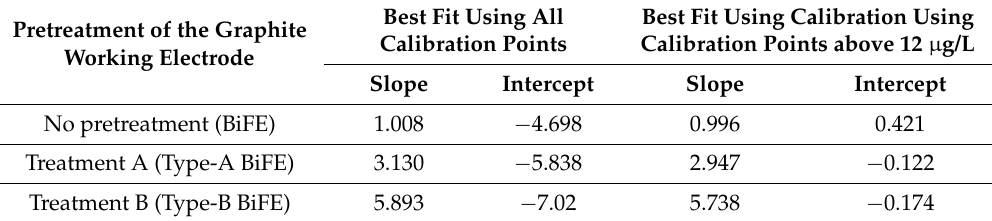
Table 1. Comparison of the calibration linear best fit parameters for Cadmium analysis as a function of the chemical pretreatment of the screen printed electrode. Experimental